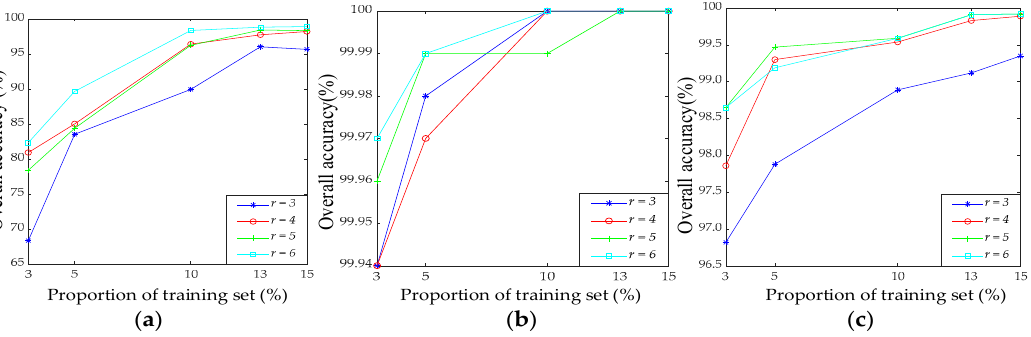
Figure 6. The overall accuracies for different r values and different training set ratios: ( a ) Indian Pines data; ( b ) Salinas-small data; ( c ) Pavia University data.